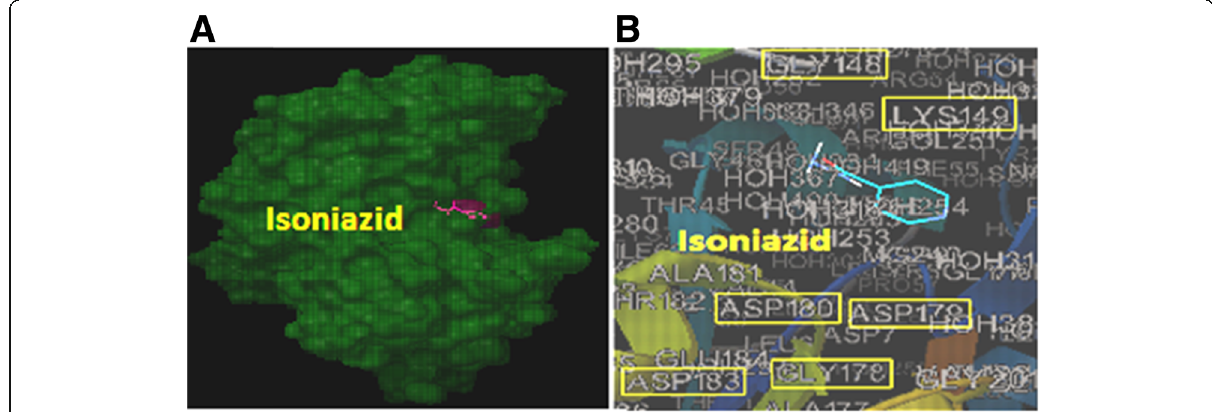
Fig. 12 a , b Docking pose of model TPP with